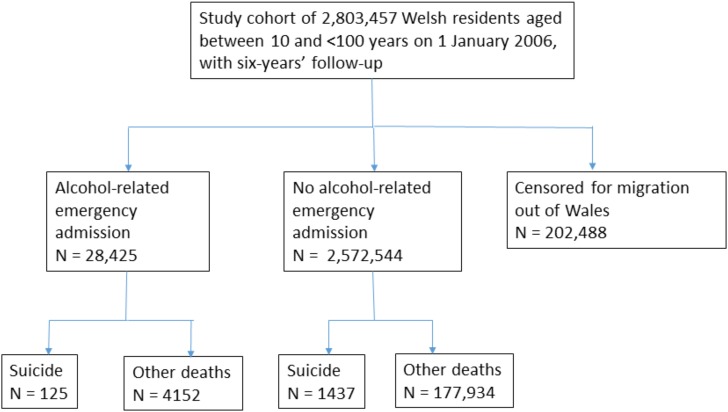
Study flow chart.